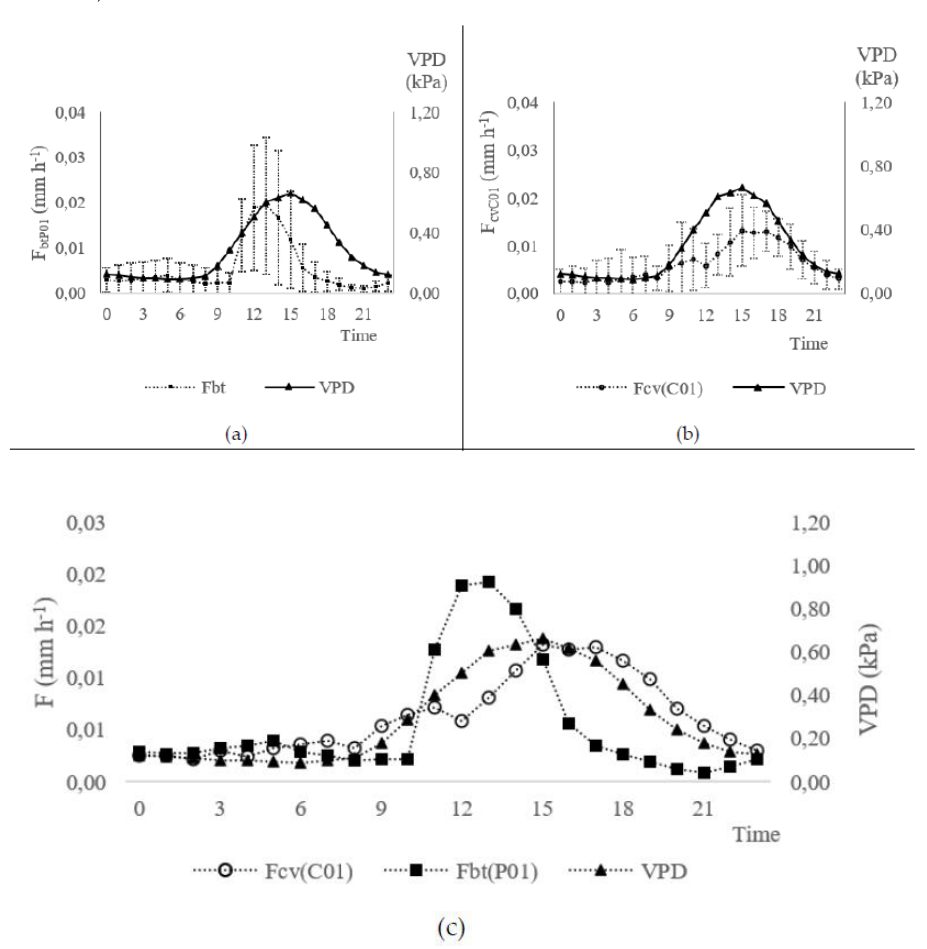
Figure 9. Hourly mean air vapour pressure deficit (VPD, kPa) from data collected at INIAV-Dois mm h − 1 ); ( c ) Comparison between F bt(P01) , F cv(C01) and VPD Portos meteorological station (days 27 March–18 April 2018) with (Experiment I): ( a ) sap flow from Biot-Granier sensors (F bt(P01) , mm h −1 ); ( b ) sap flow from the conventional Granier sensor (F cv(C01) , mm h −1 ); ( c ) Comparison between F bt(P01) , F cv(C01) and VPD estimates.